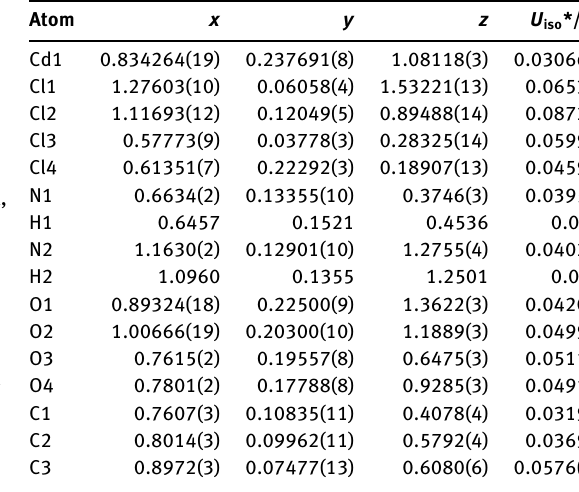
Table 2: Fractional atomic coordinates and isotropic or